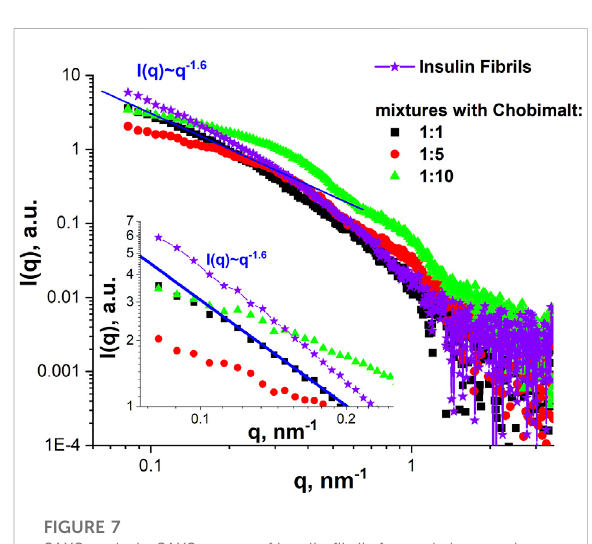
FIGURE 7 SAXS analysis. SAXS curves of insulin fi brils formed alone and inthepresenceofdifferentconcentrationsofChobimalt.Theinset graph represents the initial part of SAXS curves for q below 0.25 nm -1 together with the power-law line I(q)~q -1.6